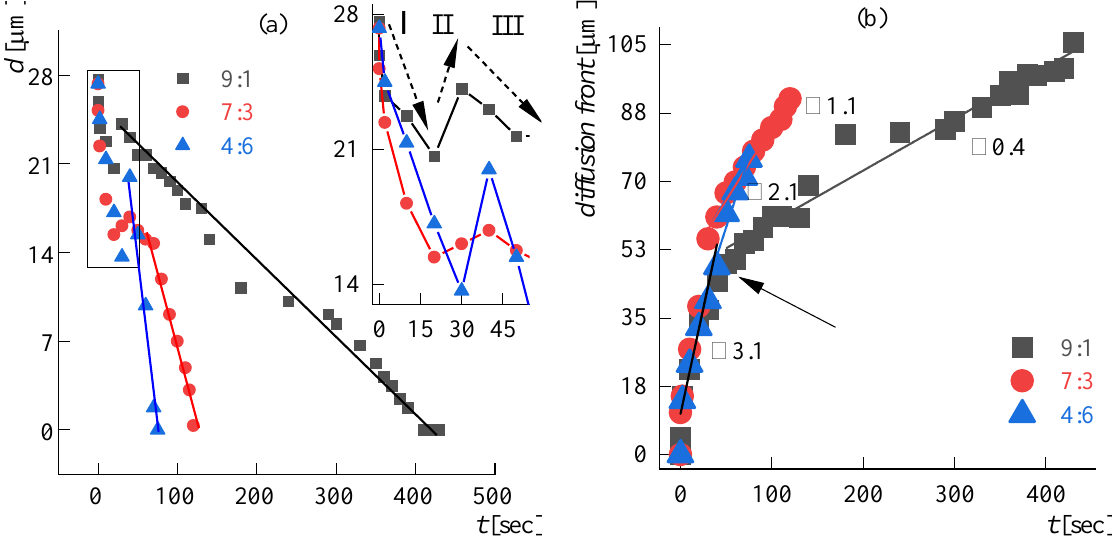
Figure 5. ( a ) Fiber dissolving kinetics in solvents with different ratios of DMSO:MeOH. Stage I corresponds to the initial dissolution of the surface layers, stage II to swelling of the bulk part of the fiber, and stage III to the monotonous subsequent dissolution of the fiber; ( b ) diffusion front propagation of a polymer solution in a solvent medium. DMSO:MeOH ratios are 4:6, 7:3, 9:1; KOH is 100 wt% of the polymer.